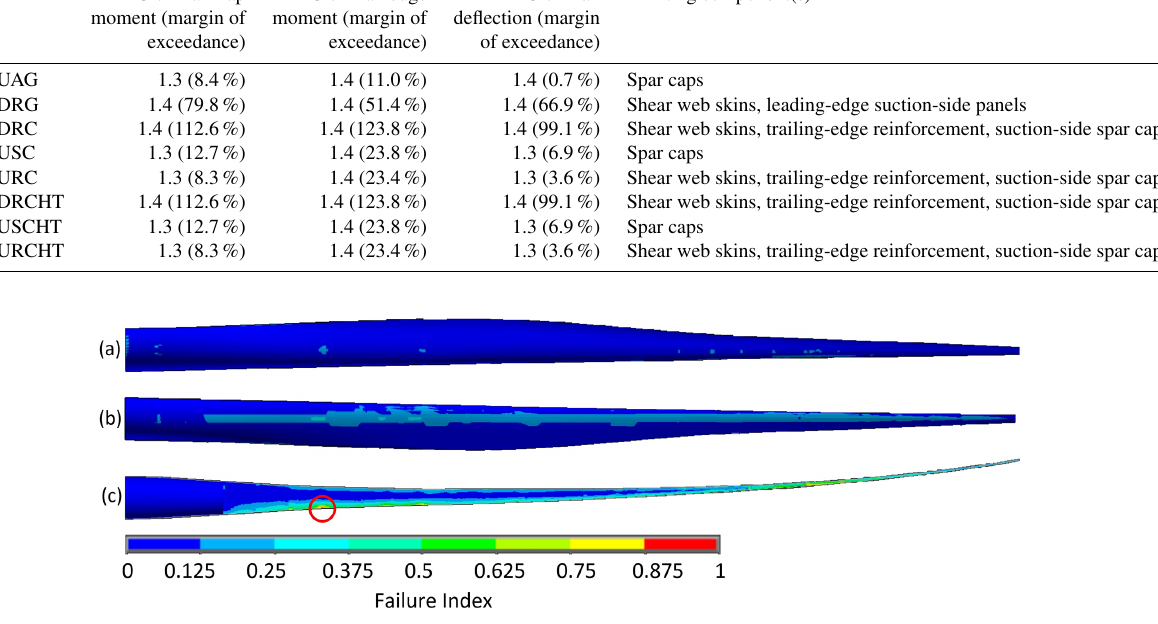
Figure 8. Tsai–Wu failure index for the optimized BAR-DRG design under critical loading, shown from the (a) pressure side, (b) suction side, and (c) cut-away view, showing the leading shear web. Vulnerable areas circled in red.